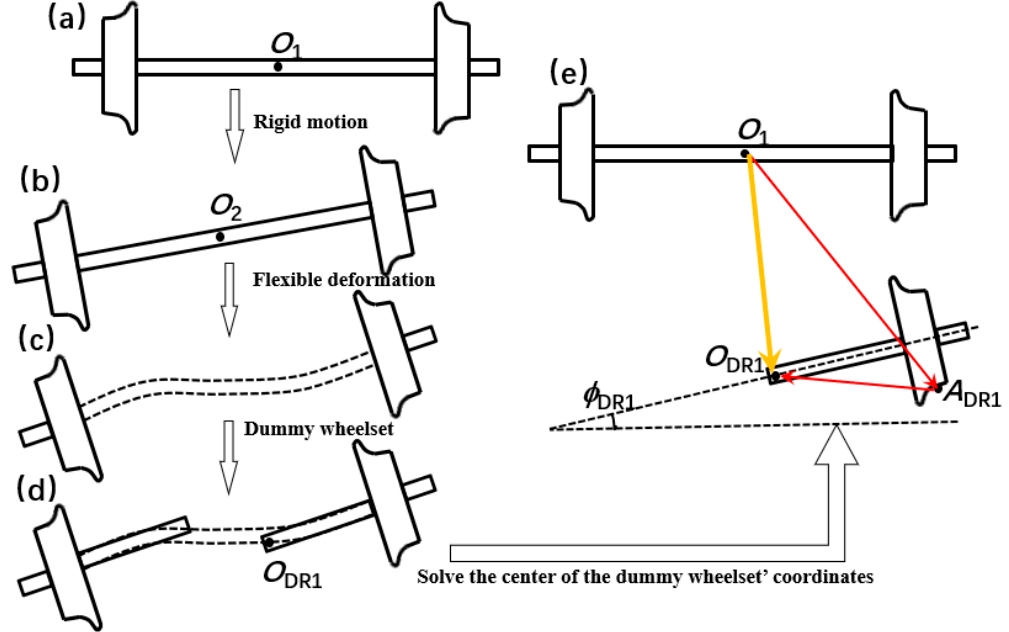
Figure 9. Modelling flexible wheelset: ( a ) Static wheelset; ( b ) The wheelset after rigid motion; ( c ) The wheelset after flexible deformation; ( d ) dummy wheelsets; ( e ) the contact geometry relation between the dummy wheelset and the two rails.